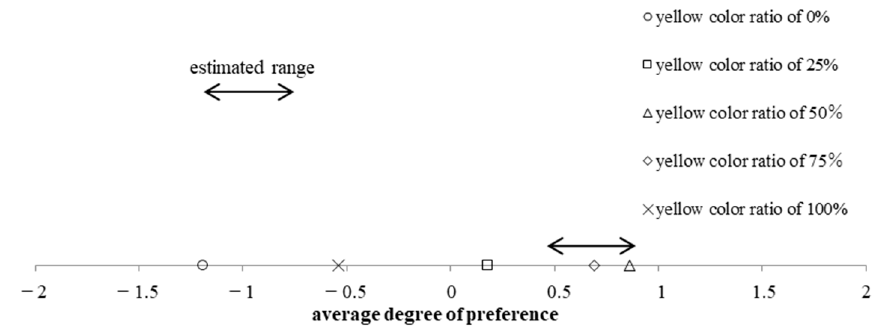
Figure 8. In terms of yellow color ratio conspicuity, the 50% color ratio was the most conspicuous result. There was no significant difference between the 50% and 75% yellow color ratios.